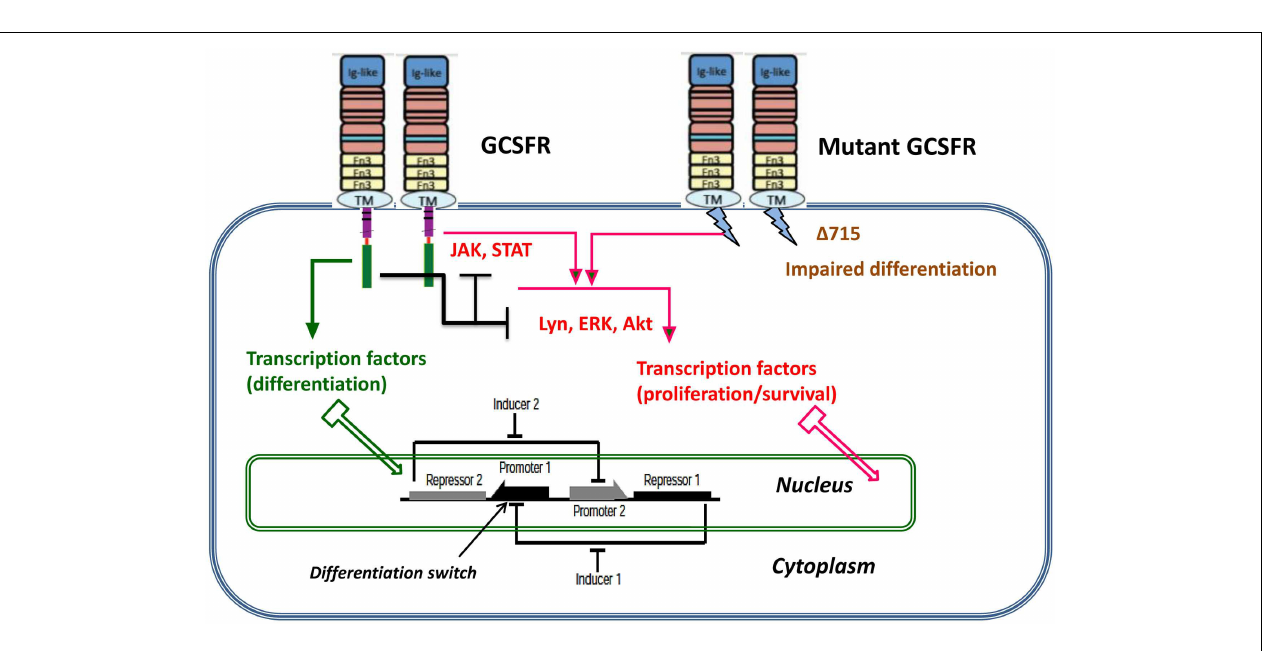
these signaling networks promote proliferation, survival, and differentiation. In patients with severe congenital neutropenia, the earliest known mutation to contribute to transformation to secondary MDS or AML is a nonsense mutation in the GCSFR gene.This mutation leads to a truncated receptor, GCSFR delta